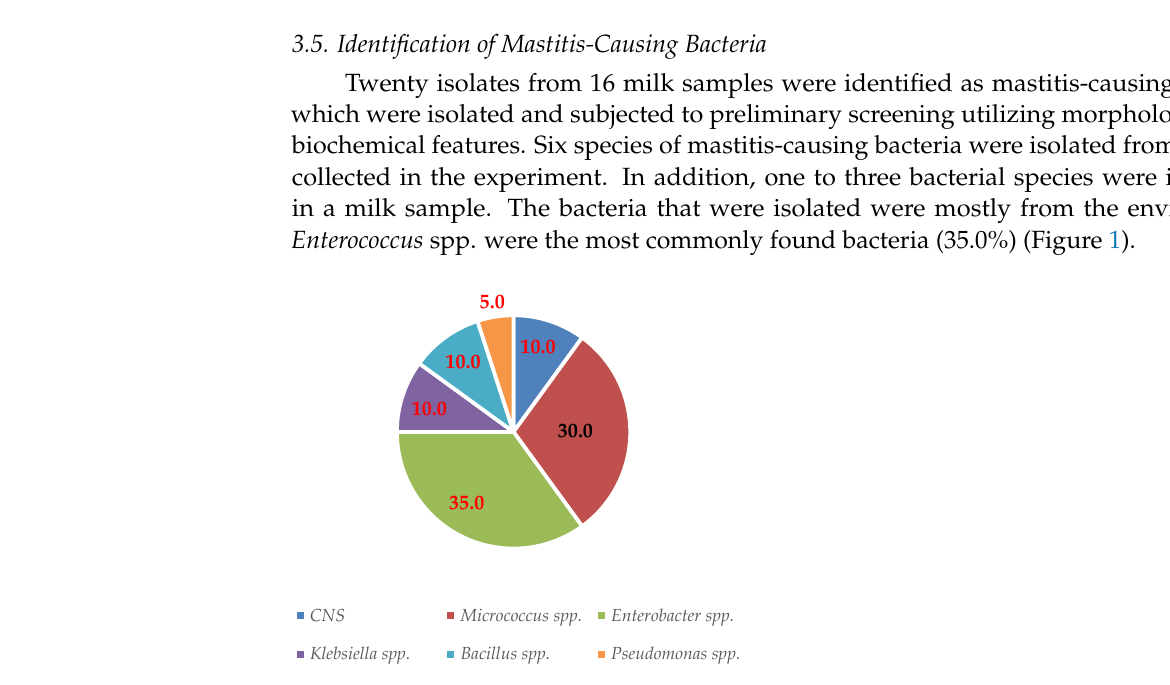
Figure 1. Distribution of isolated bacterial species (%) found in milk.